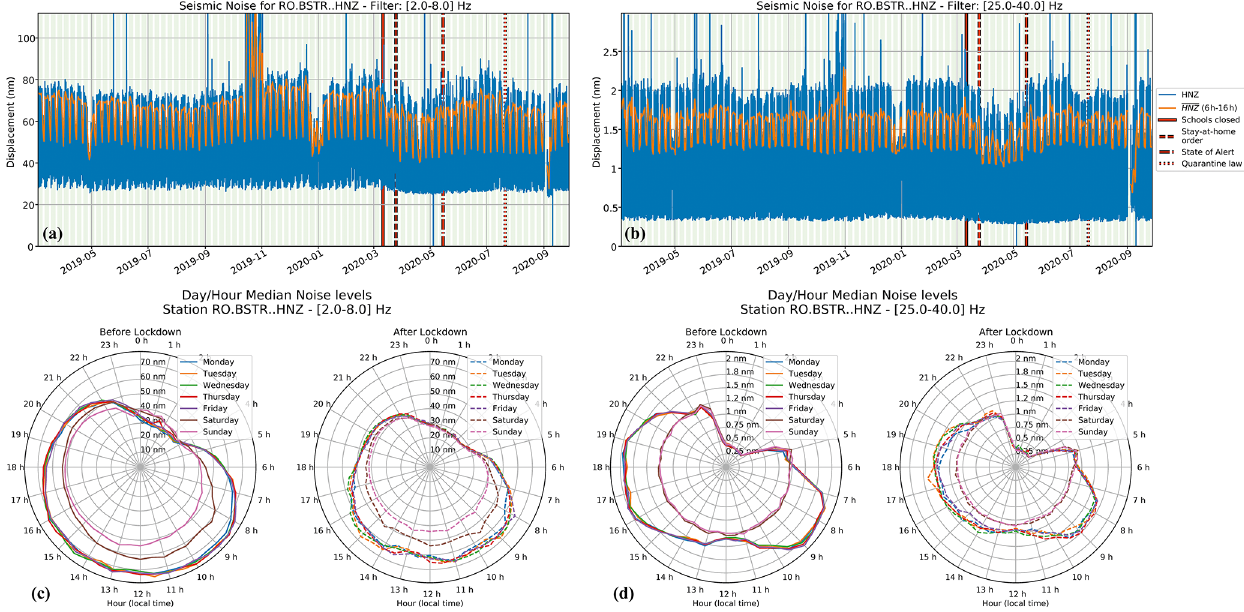
Figure 4. Lockdown effects on seismic noise in downtown Bucharest (BSTR). (a, b) Evolution of DRMS for the March 2019–September 2020 period based on displacement data in the bands 2–8Hz (a) and 25–40Hz (b) . Panels (c, d) display 24h clock plots showing average displacement variation for each day of the week and for the period before lockdown (27 January–24 March 2020) and during lockdown (25 March–17 May 2020) for the bands 2–8Hz (c) and 25–40Hz (d) . The location of the station is displayed in Fig.